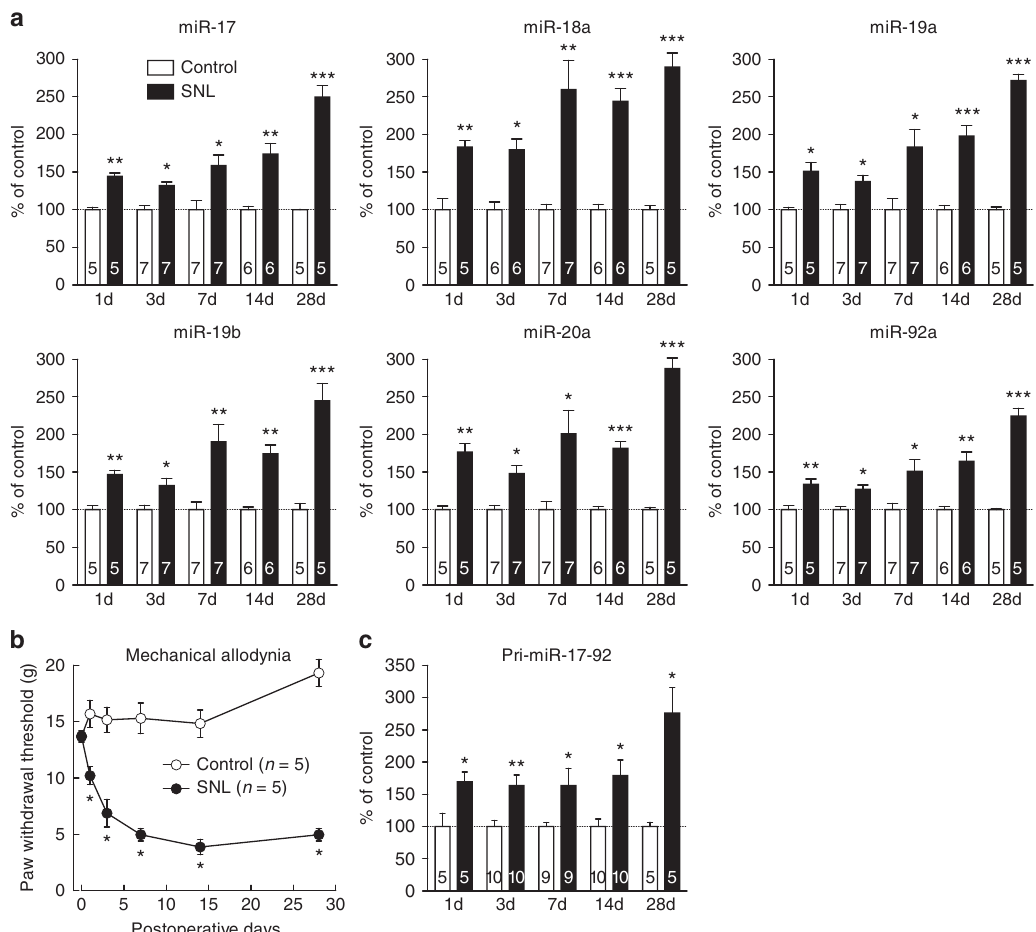
Figure 1 | miR-17-92 cluster upregulation in L5 DRG neurons after nerve injury. ( a , c ) Change in expression of mature miRNAs of the miR-17-92 cluster ( a ) and primary transcripts of miR-17-92 ( c ) in the L5 DRG over time after SNL. Numbers of samples are indicated at the base of each bar. * P o 0.05, ** P o 0.01 and *** P o 0.001 (miR-17, P ¼ 0.002 for 1d, P ¼ 0.010 for 3d, P ¼ 0.017 for 7d, P ¼ 0.004 for 14d and P o 0.001 for 28d; miR-18a, P ¼ 0.006 for 1d, P ¼ 0.011 for 3d, P ¼ 0.005 for 7d, P o 0.001 for 14d and P o 0.001 for 28d; miR-19a, P ¼ 0.017 for 1d, P ¼ 0.033 for 3d, P ¼ 0.022 for 7d, P o 0.001 for 14d and P o 0.001 for 28d; miR-19b, P ¼ 0.002 for 1d, P ¼ 0.049 for 3d, P ¼ 0.005 for 7d, P ¼ 0.002 for 14d and P o 0.001 for 28d; miR-20a, P ¼ 0.008 for 1d, P ¼ 0.015 for 3d, P ¼ 0.020 for 7d, P o 0.001 for 14d and P o 0.001 for 28d; miR-92a, P ¼ 0.006 for 1d, P ¼ 0.016 for 3d, P ¼ 0.011 for 7d, P ¼ 0.002 for 14d and P o 0.001 for 28d; pri-miR-17-92, P ¼ 0.043 for 1d, P ¼ 0.005 for 3d, P ¼ 0.048 for 7d, P ¼ 0.022 for 14d and P ¼ 0.011 for 28d) compared with the contralateral intact side, paired t -test. ( b ) Paw withdrawal responses to mechanical stimuli evaluated on the SNL and contralateral sides. Error bars are s.e.m. * P o 0.05 ( P ¼ 0.043 for 3d, P ¼ 0.042 for 7d, P ¼ 0.041 for 14d and P ¼ 0.039 for 28d) compared with the contralateral side, Mann–Whitney U changes 20 available in Gene Expression Omnibus (www.ncbi.nlm.nih.gov/geo/; GEO accession GSE24982)